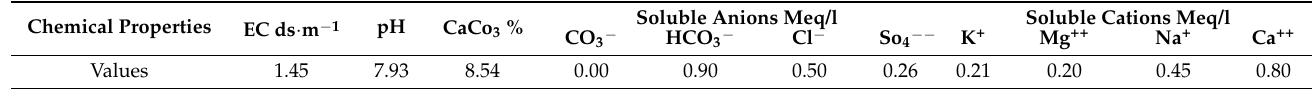
Table 12. The chemical properties of the tested